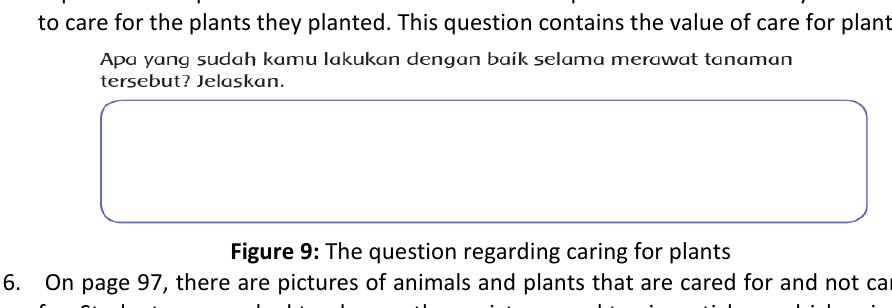
Figure 9: The question regarding caring for plants